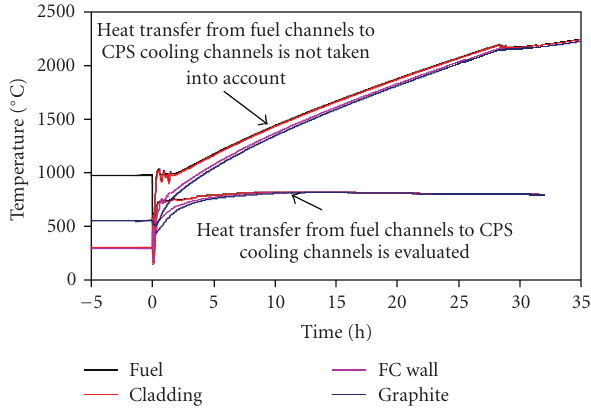
Figure 18: MCP pressure header break with failure of ECCS pumps. Behaviour of core components temperatures.